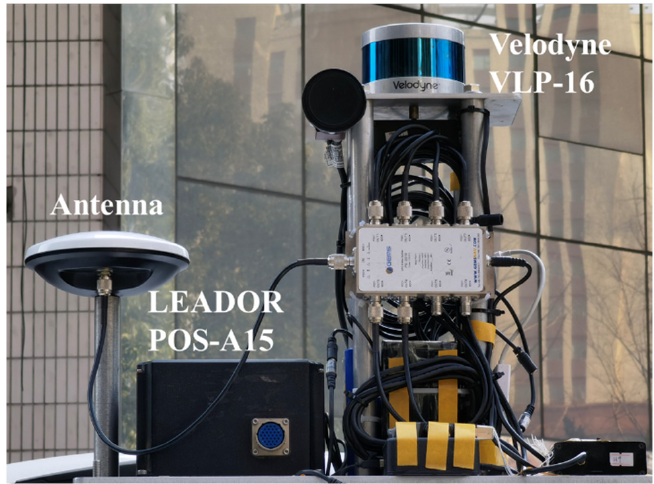
Figure 8. Setup of the data collecting system.